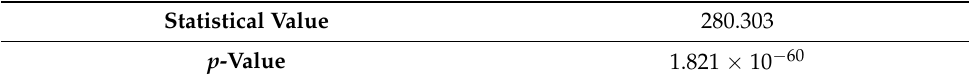
Table 5. Friedman test results applied to DNN model